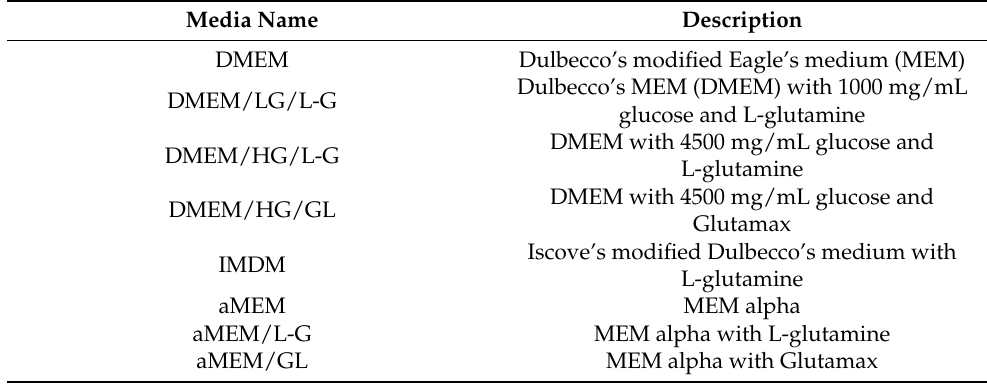
Table 1. Different types of basal